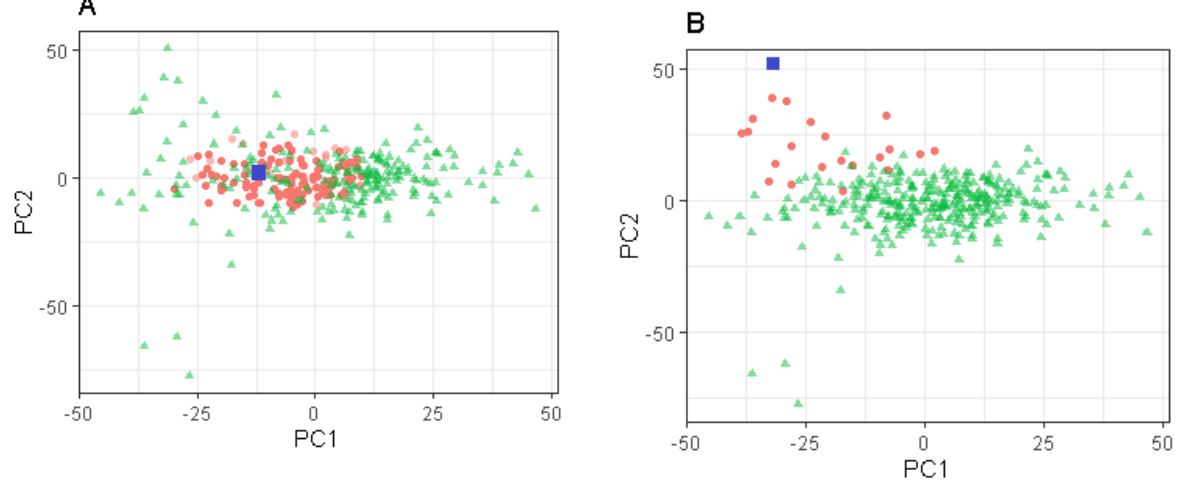
Figure 3. Neighbours selected according to the MBIC penalty after standardising the spectra for a target spectrum (blue square) that lies in the centre (( A ) n = 133, red dots) and at the edge (( B ) n = 21, red dots) of the four − dimensional principal component space. The green triangles represent the other spectra not selected as neighbours.